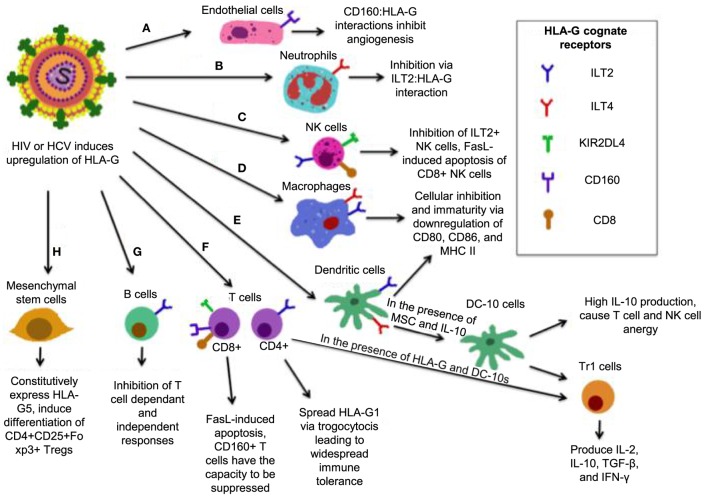
Simplified model of how human leukocyte antigen (HLA)-G mediates its inhibitory functions. (A) Interactions between CD160 on endothelial cells with HLA-G inhibit angiogenesis. (B) ILT2 expression on neutrophils renders them susceptible to inhibition by HLA-G, resulting in a tolerogenic phenotype. (C) The interaction between HLA-G and CD8 on some natural killer (NK) cells triggers FasL-mediated apoptosis, while ILT2:HLA-G impairs NK cell function. (D) ILT2 and immunoglobulin-like transcript 4 (ILT4) present on macrophages interacts with HLA-G, resulting a tolerogenic, immature phenotype with reduced activation markers CD80/86, and major histocompatibility complex (MHC) II. (E) In the presence of HLA-G, mesenchymal stem cells (MSC), and HLA-G, dendritic cells (DCs) that express ILT2 and ILT4 differentiate into DC-10s, which produce high IL-10 and mediate differentiation of Tr1 cells and immaturity of macrophages, and induce widespread immune tolerance. (F) HLA-G:CD8 triggers FasL-mediated apoptosis. KIR2DL4:HLA-G inhibits cytotoxicity, while CD160:HLA-G results in inhibition of proliferation. Upon induction of HLA-G1 on ILT4+ CD4+ T-cells, DC-10 are able to cause their differentiation into Tr1 regulatory cells, which secrete high IL-10 and TGF-β and kill myeloid cells in a Grzm-dependent manner. (G) B-cells express ILT2, it is likely that B-cells are susceptible to HLA-G-mediated suppression. (H) MSC constitutively express HLA-G5 and via HLA-G5 suppress other cells. MSCs also induce CD4+ CD25+ Foxp3+ regulatory T cells (Tregs) via cell-to-cell interaction.